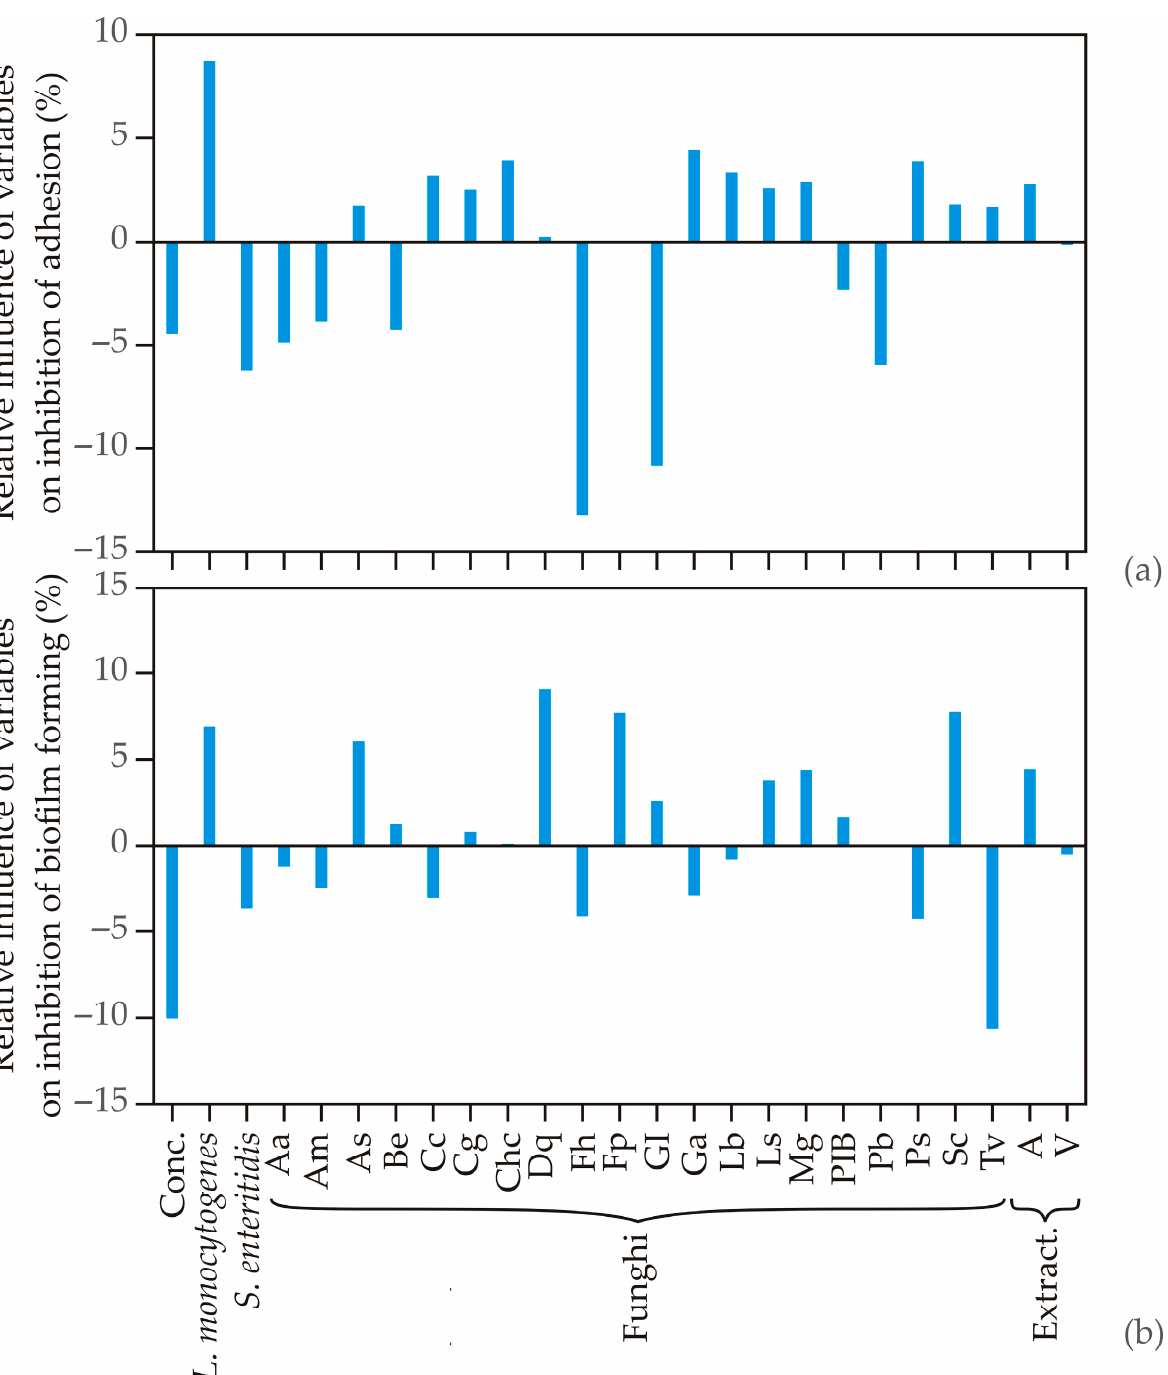
Figure 3. The relative importance of twenty-five input variables on ( a ) the inhibition of adhesion and ( b ) inhibition of the bio fi lm-forming process.